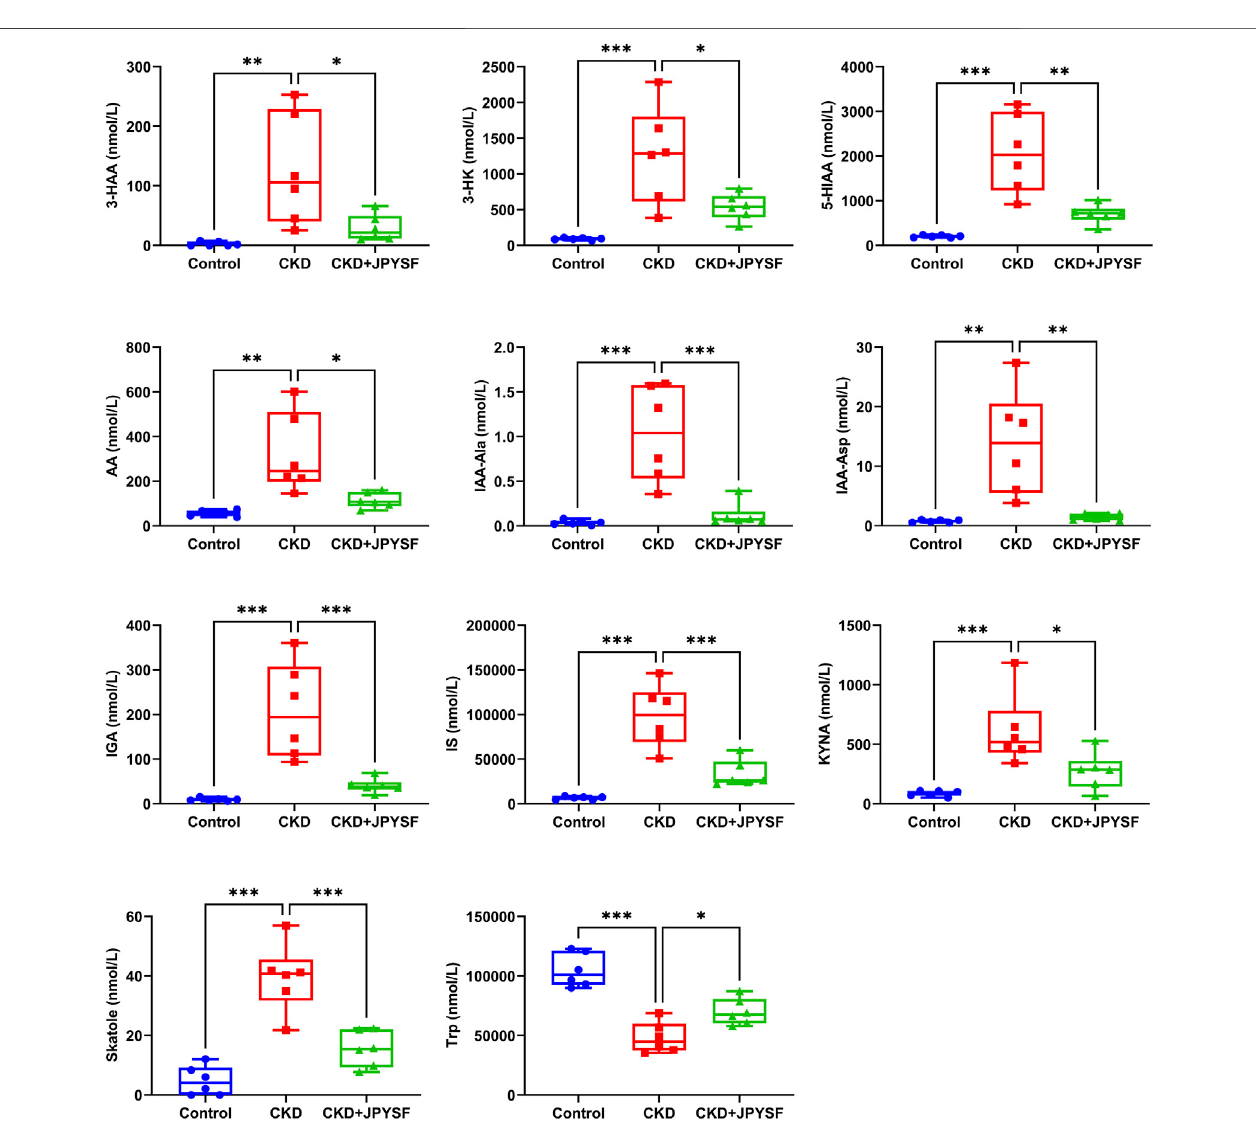
FIGURE 5 | Effects of JPYSF on 11 tryptophan metabolites in adenine-induced CKD rats. Values are expressed as mean ± SEM, n = 6 rats per group (* p < 0.05, ** p < 0.01, and *** p < 0.001 between the indicated two groups).